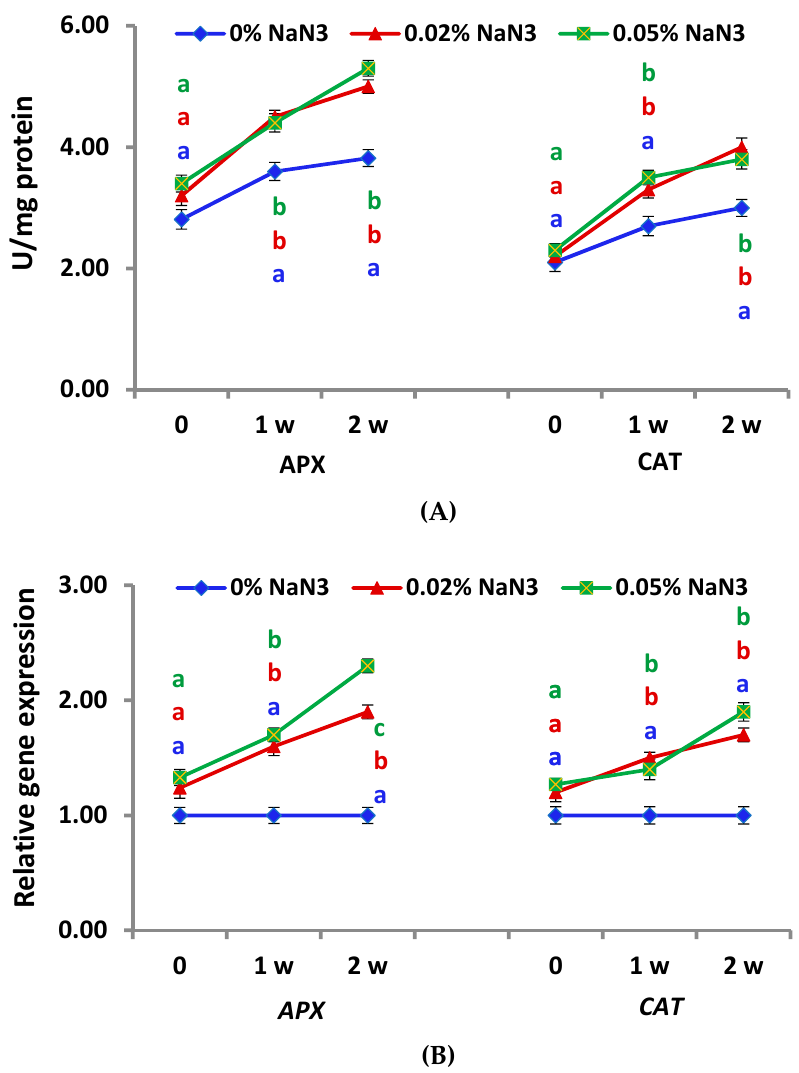
Figure 5. Activity ( A ) and gene expression levels ( B ) of APX and CAT enzymes in okra plants grown from NaN3-treated seeds under waterlogging conditions ten weeks after planting (WAP). Values = mean ± SD, n = 4. Mean values with similar letters at the same WAP are not significantly different at p ≤ 0.05.